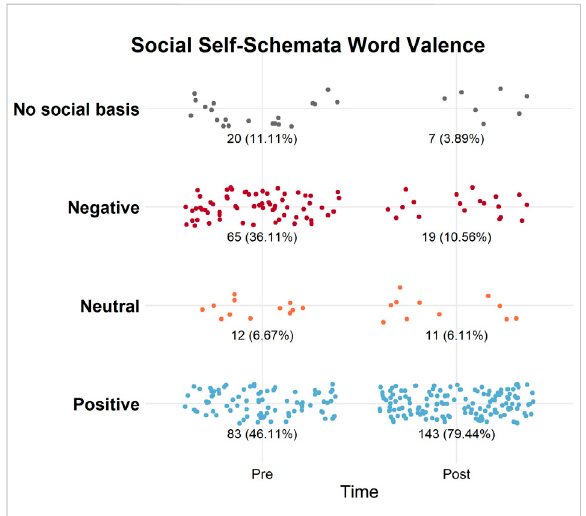
FIGURE 6 Social-self schemata word valence across time. Number of word responses of valences used to describe the sense of social self at pre and post interviews (N = 180). The number of no social basis (grey) and negative words (red) decreased between pre andpostinterviews.Morepositivewords(blue)wereusedafterthe training. The number of neutral words (orange) used was comparable between pre and